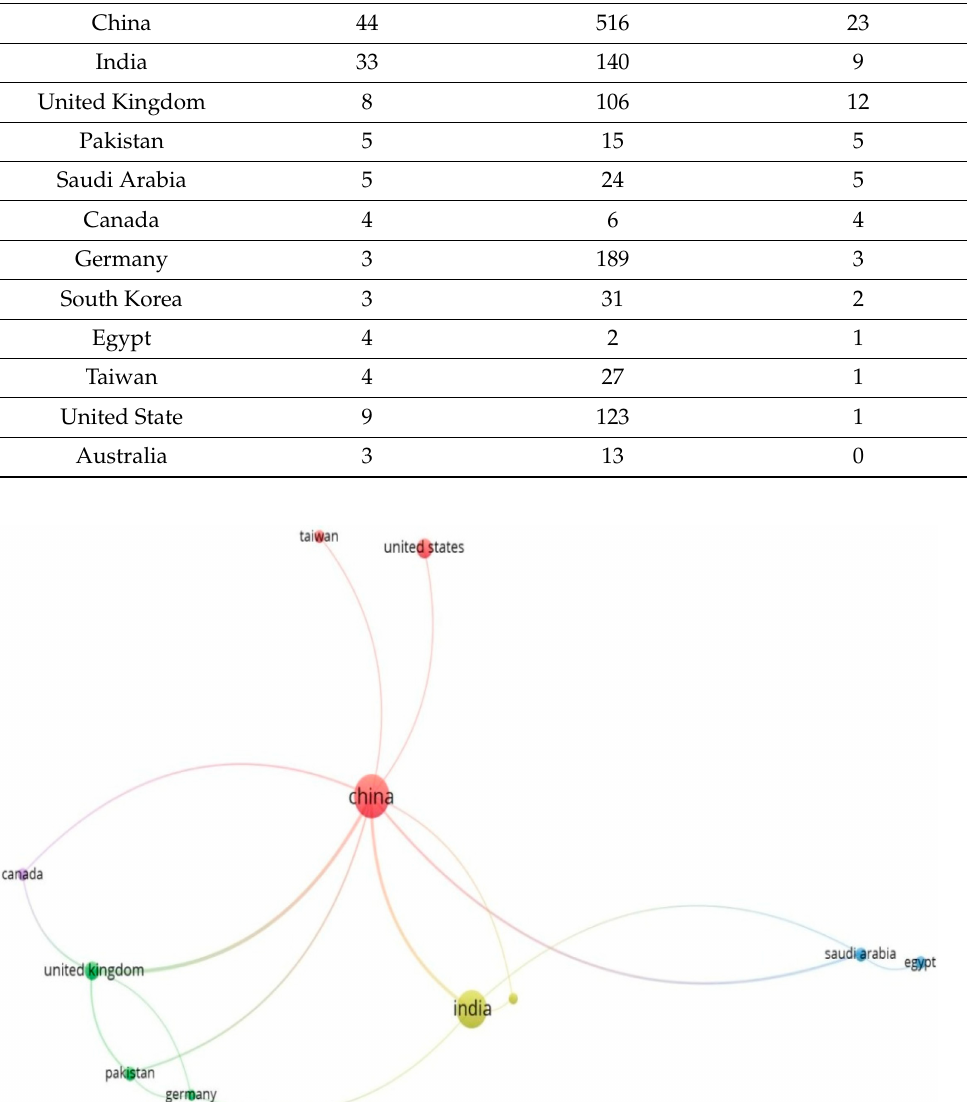
Figure 25. Country Wise Document X Citation Network (Source: https://www.vosviewer.com (accessed on 14 September